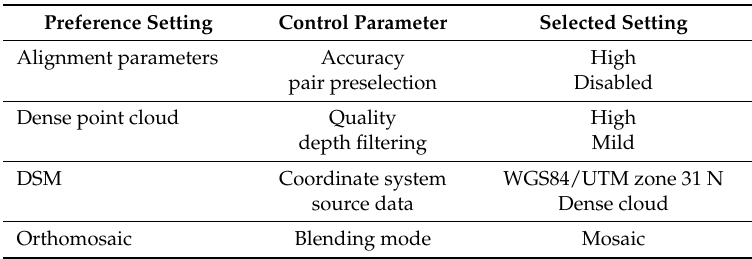
Table 3. Processing parameters selected for Digital Surface Model (DSM) and orthomosaic generation procedure by Agisoft Photoscan